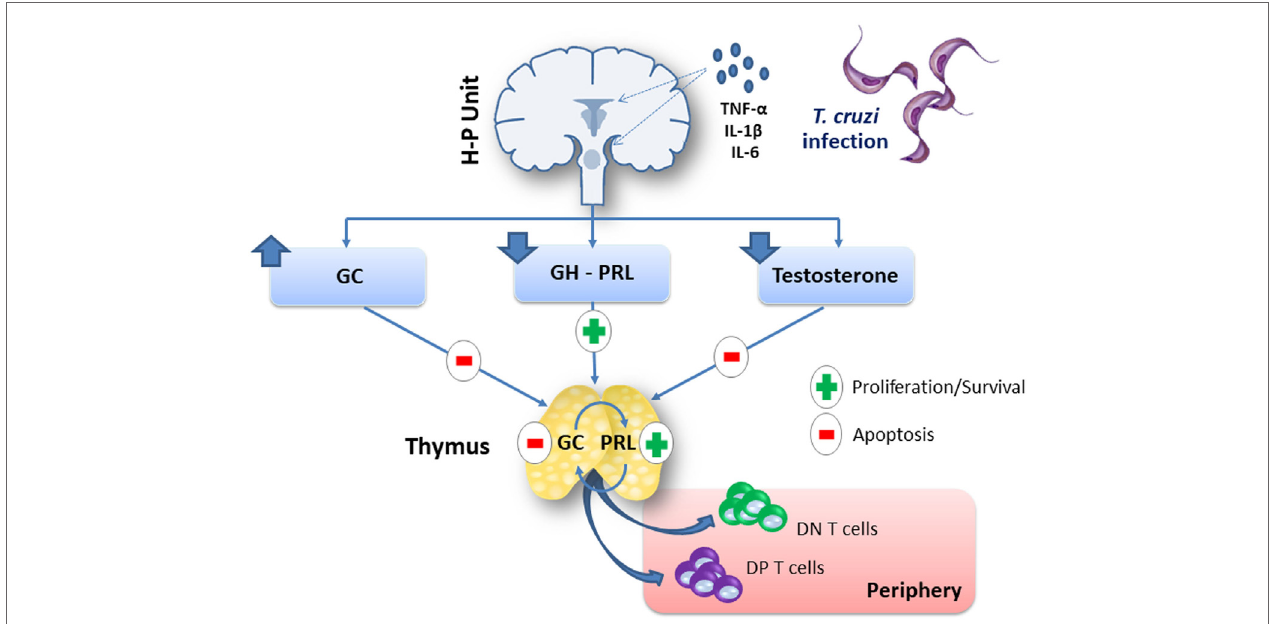
FiGURe 1 | Systemic and intrathymic hormonal imbalance affects the thymus during experimental Trypanosoma cruzi infection. Acute T. cruzi infection in mice induces a rise in plasma levels of proinflammatory cytokines, which are involved in the hyperactivation of the hypothalamus–pituitary–adrenal (HPA) axis. Pro- inflammatory cytokines can enhance HPA axis activation, by acting at the hypothalamus–pituitary unit and/or on peripheral glands, i.e., the adrenals. In situ inflammatory reactions caused by T. cruzi -derived antigens or structural changes like vascular alterations or an enhanced extracellular matrix deposition in the endocrine microenvironment may also lead to sustain glucocorticoid hormone (GC) levels. The increment of systemic and intrathymic GC levels causes thymic atrophy by depletion of CD4 + CD8 + double-positive (DP) thymocytes through apoptosis. In parallel, there is an abnormal export of immature DP and double-negative (DN) T cells to the periphery of the immune system. Growth hormone (GH) and prolactin (PRL) have positive effects upon the thymus, but T. cruzi infection decreases GH and PRL production by pituitary cells. Male animals acutely infected with T. cruzi also present a reduction in serum testosterone levels, although DP thymocyte death seems to be induced by this androgen, whereas testosterone supplementation induced a diminution in thymocyte proliferation. Abbreviation: H–P unit, hypothalamus–pituitary unit.